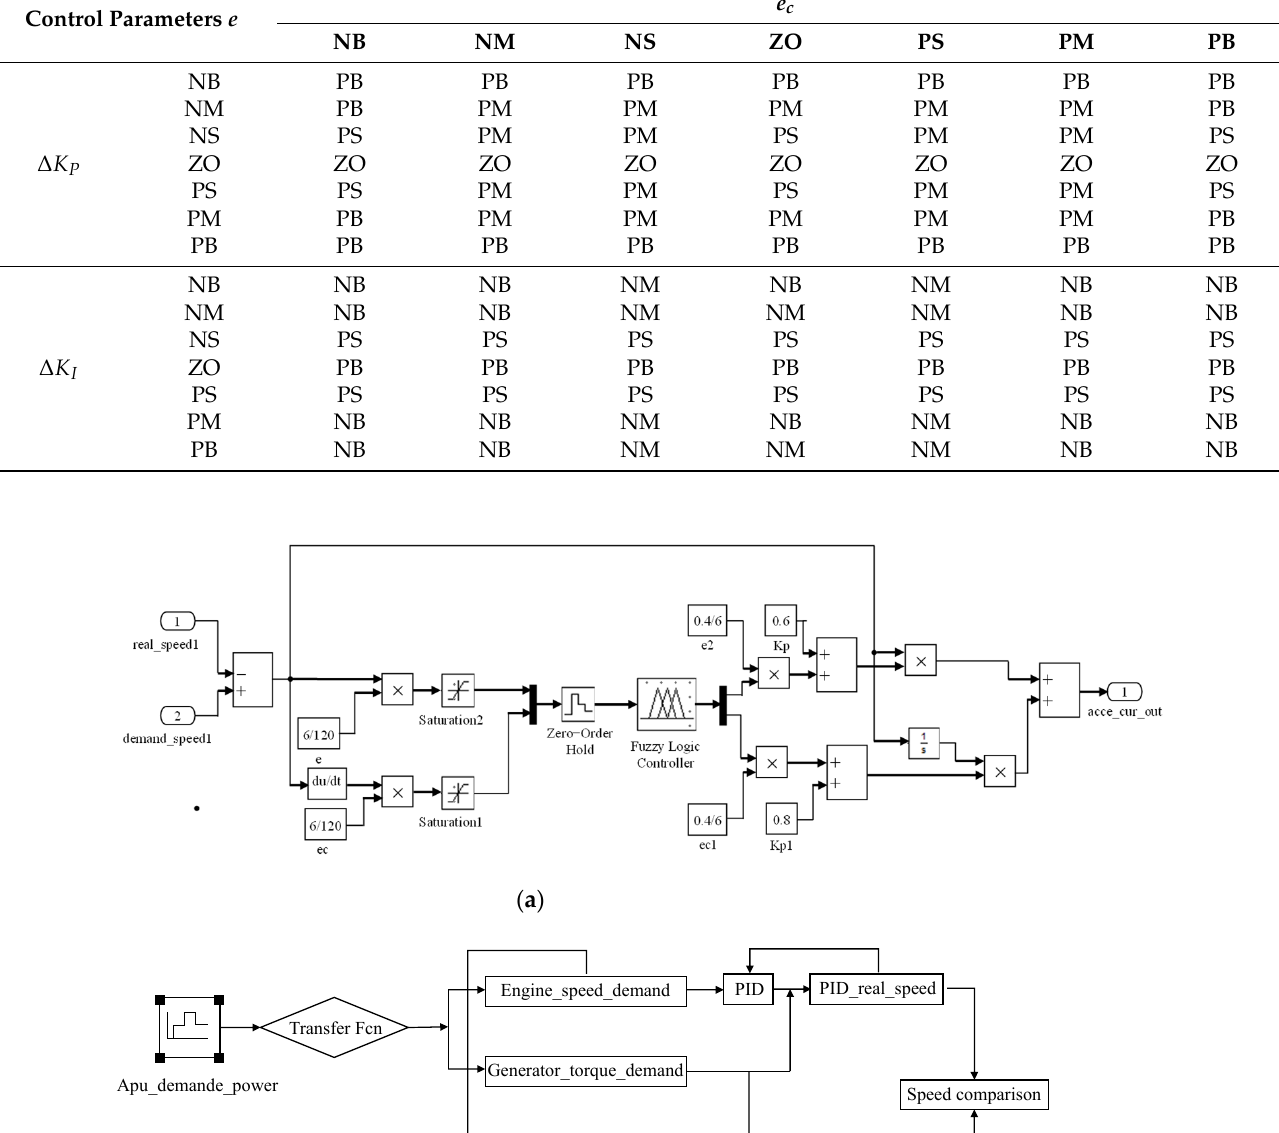
4 of 14 Table 1. Fuzzy control table for ∆𝐾 (cid:3017) and ∆𝐾 (cid:3010) . Control Parameters 𝒆